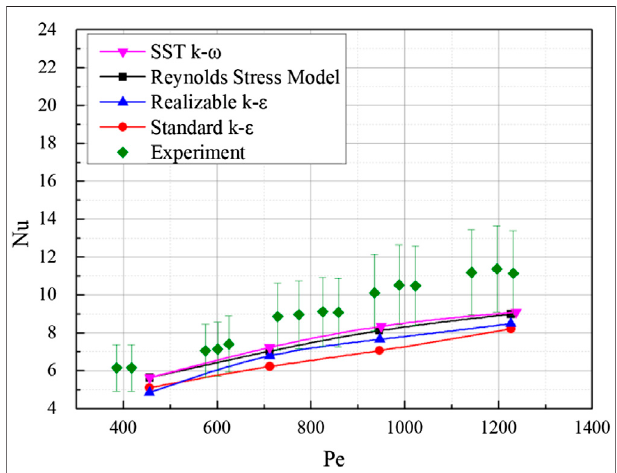
FIGURE 3 | The local Nu at ML3 estimated by different turbulence models against the experiment.